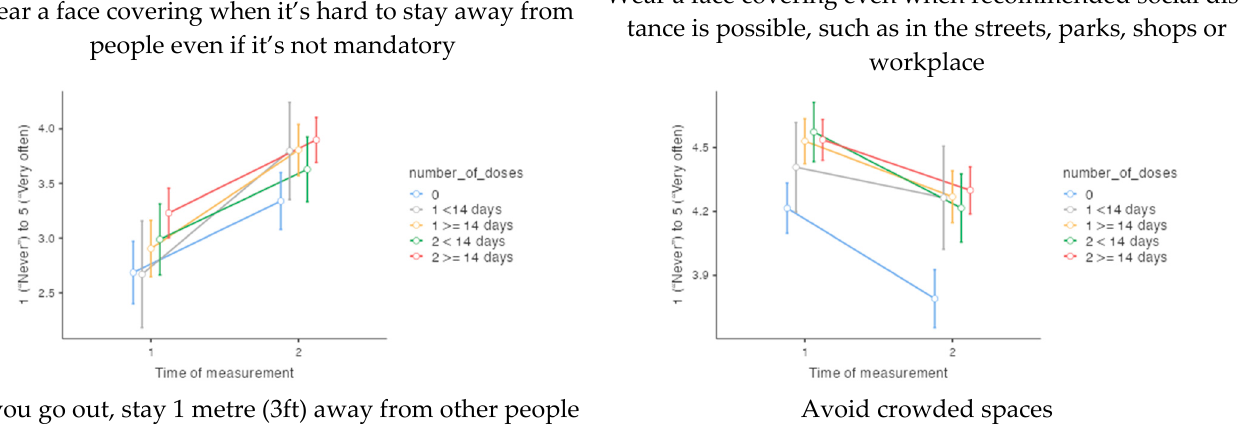
Figure 1. Frequencies of 14 precautionary behaviours at time of measurement 1 (141 days before the start of the vaccination programme) and time of measurement 2 (161 days after the start of the vaccination programme), according to number of doses at time of measurement 2.